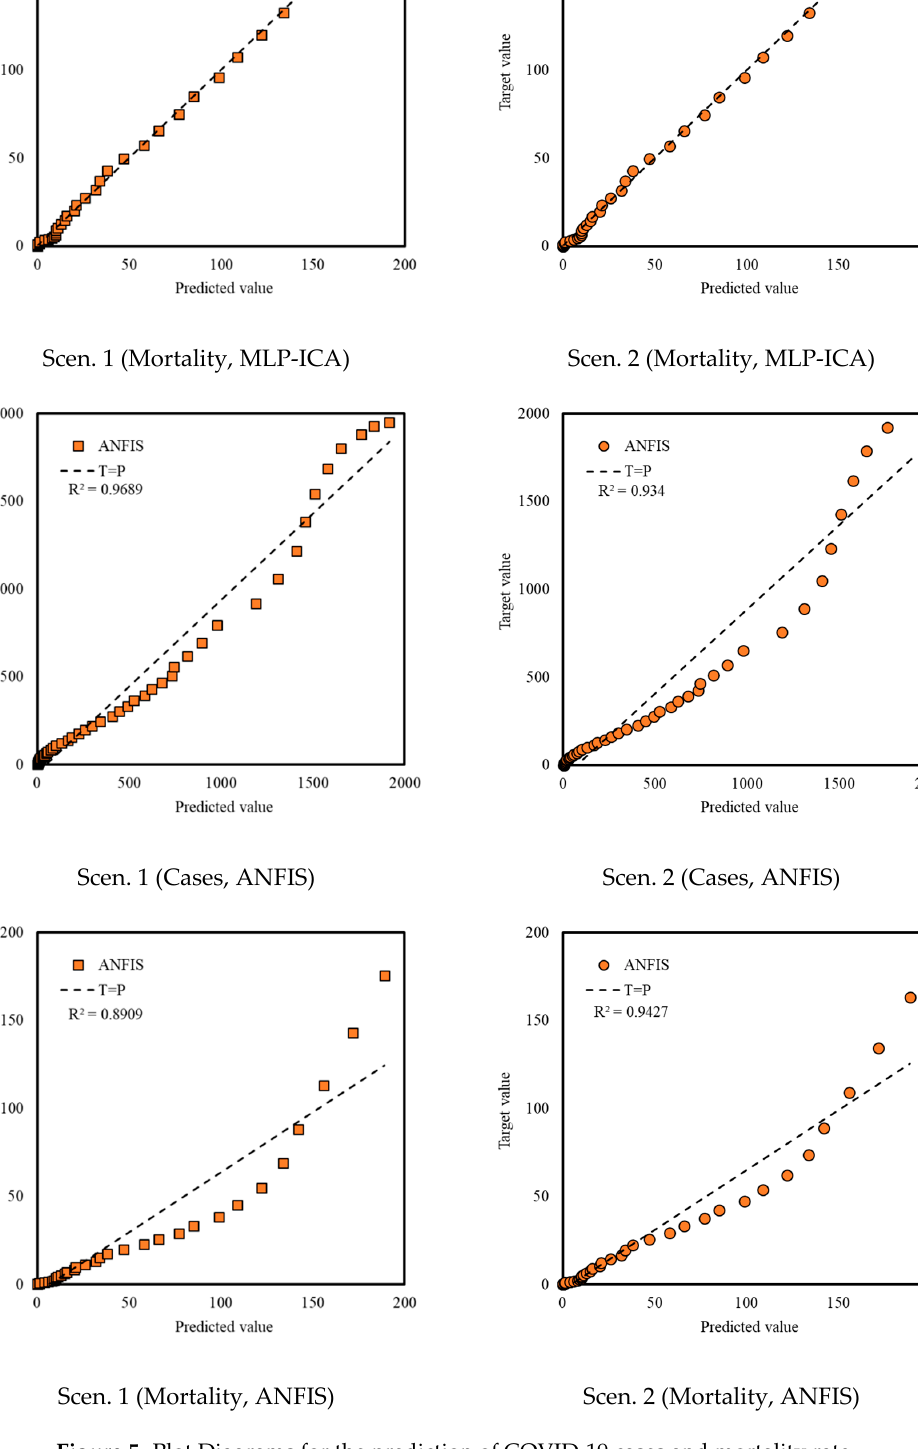
Figure 5. Plot Diagrams for the prediction of COVID-19 cases and mortality rate. From considering Scen. 1 for mortality model using MLP-ICA method and Scen. 2 for mortality model using MLP-ICA method, the differences are negligible. It is, therefore, worth mentioning that